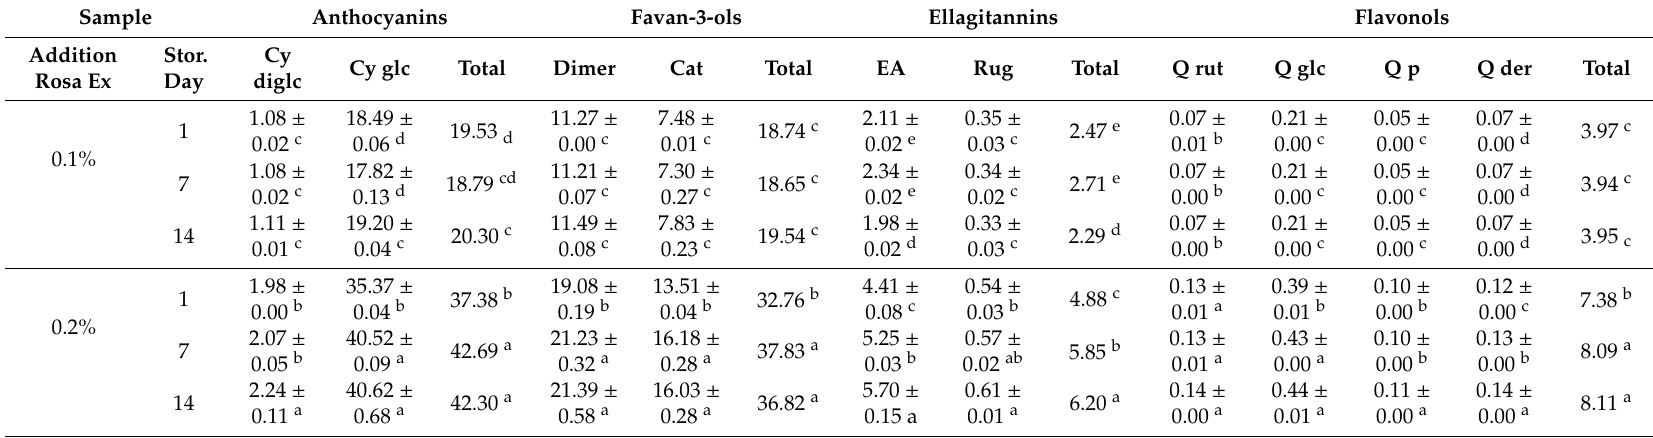
Table 6. Content of anthocyanins, favan-3-ols, ellagitannins and flavonols (mg / L) in yoghurts with the addition of 0.1% and 0.2% of Rosa spinosissima fruits extract during 14 days of